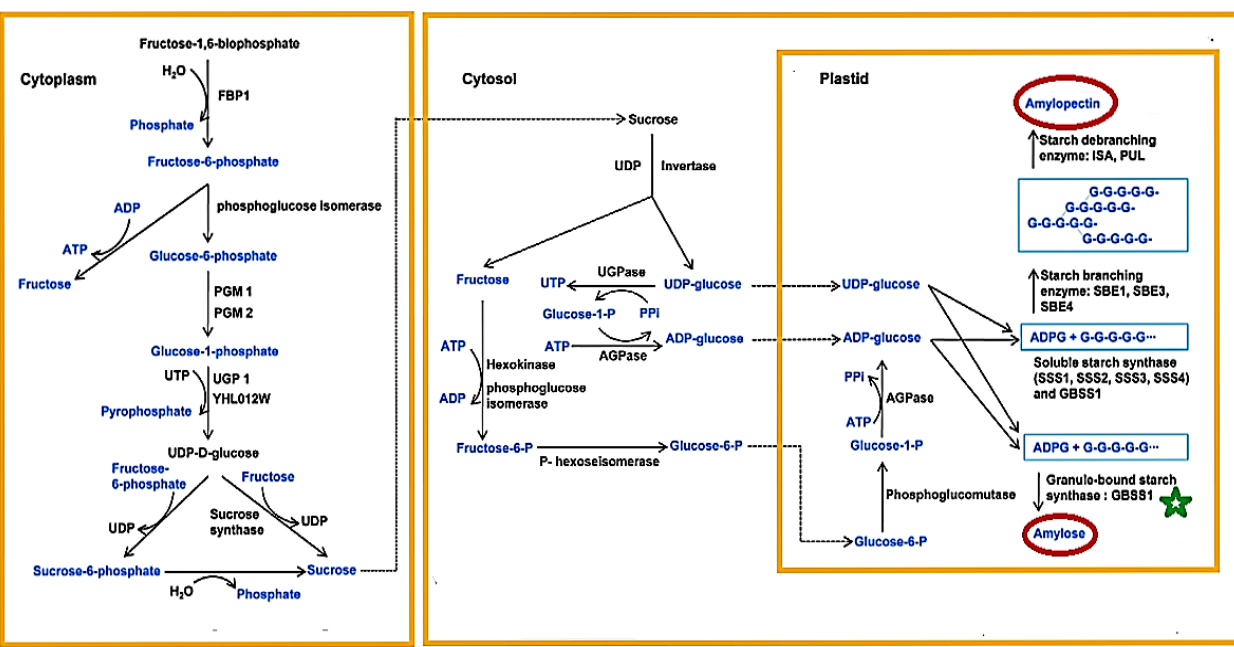
Figure 2. “Main pathway of starch biosynthesis including sucrose synthesis, sucrose degradation and starch synthesis in rice” [8]. “FBP1, fructose-1,6-bisphophatase1; PGM, phosphoglucomutase; AGPase, ADP-glucose pryophosphorylase; PPi, pyrophosphate” [8]. For both gel consistency and amylose content, waxy (GBSSI, marked with a green star) serves as a vital/critical gene, but it has a minor influence on the temperature of gelatinization. The amylose and amylopectin circled in red color are very important in starch modification. Source: Sun et al. [8].